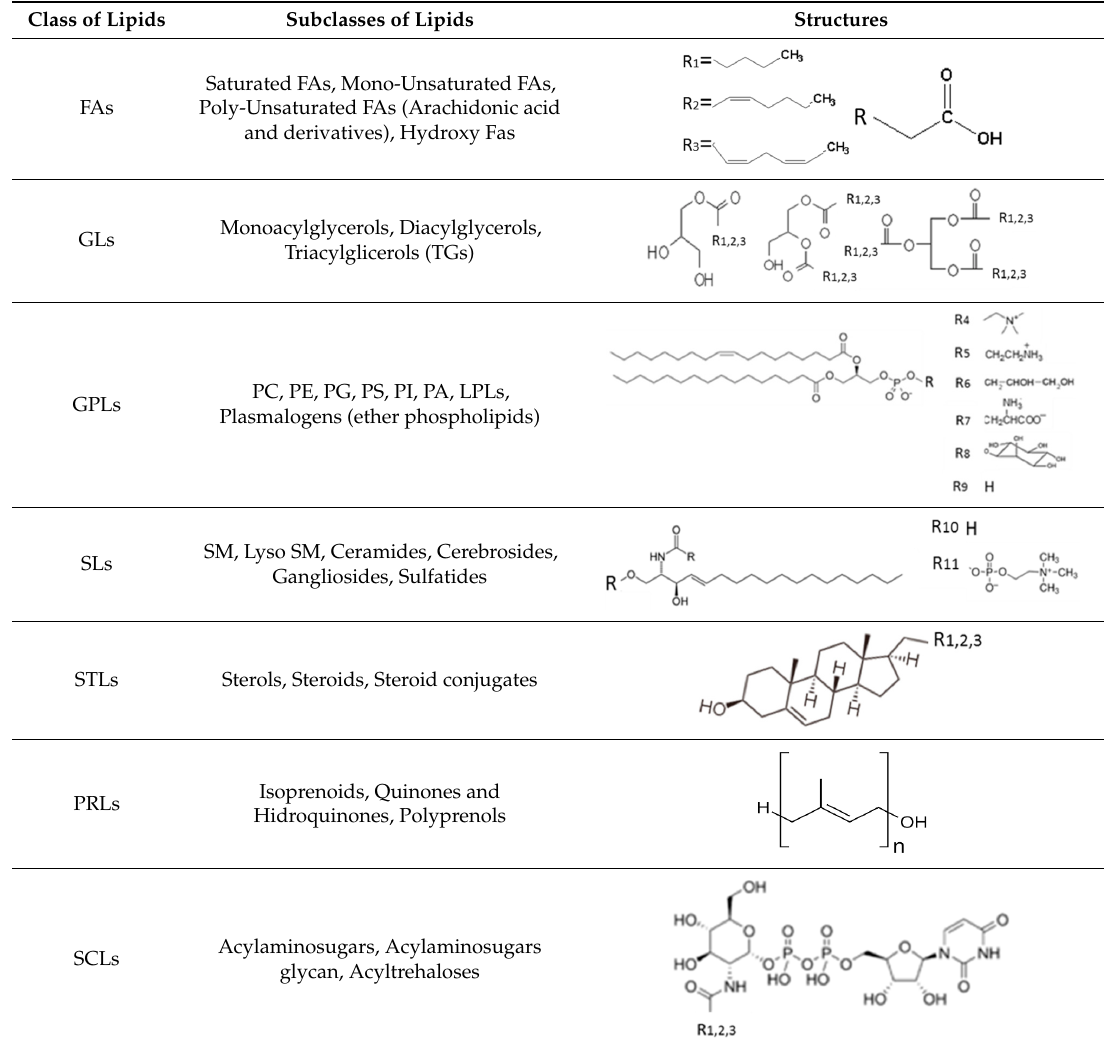
3 of 25 Table 1. Classification of lipids based on structures. The table lists different lipid classes and the main subclasses cited in the text. FAs: Fatty acids; GLs: Glycerolipids; GPLs: Glycerophospholipids;